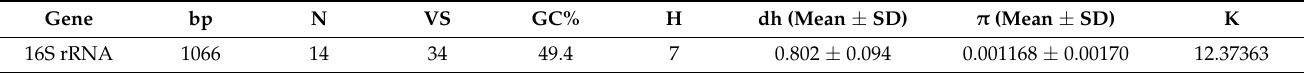
Table 3. Polymorphisms and diversity of 16Sr RNA sequences of Ehrlichia spp. obtained from coatis